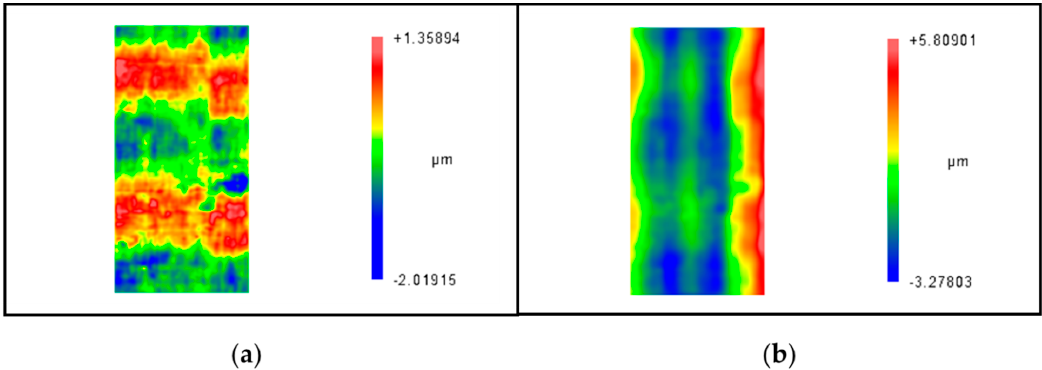
Figure 17. Error surfaces generated by the same workpiece. ( a ) Roundness error surface; ( b ) cylindricity error surface.